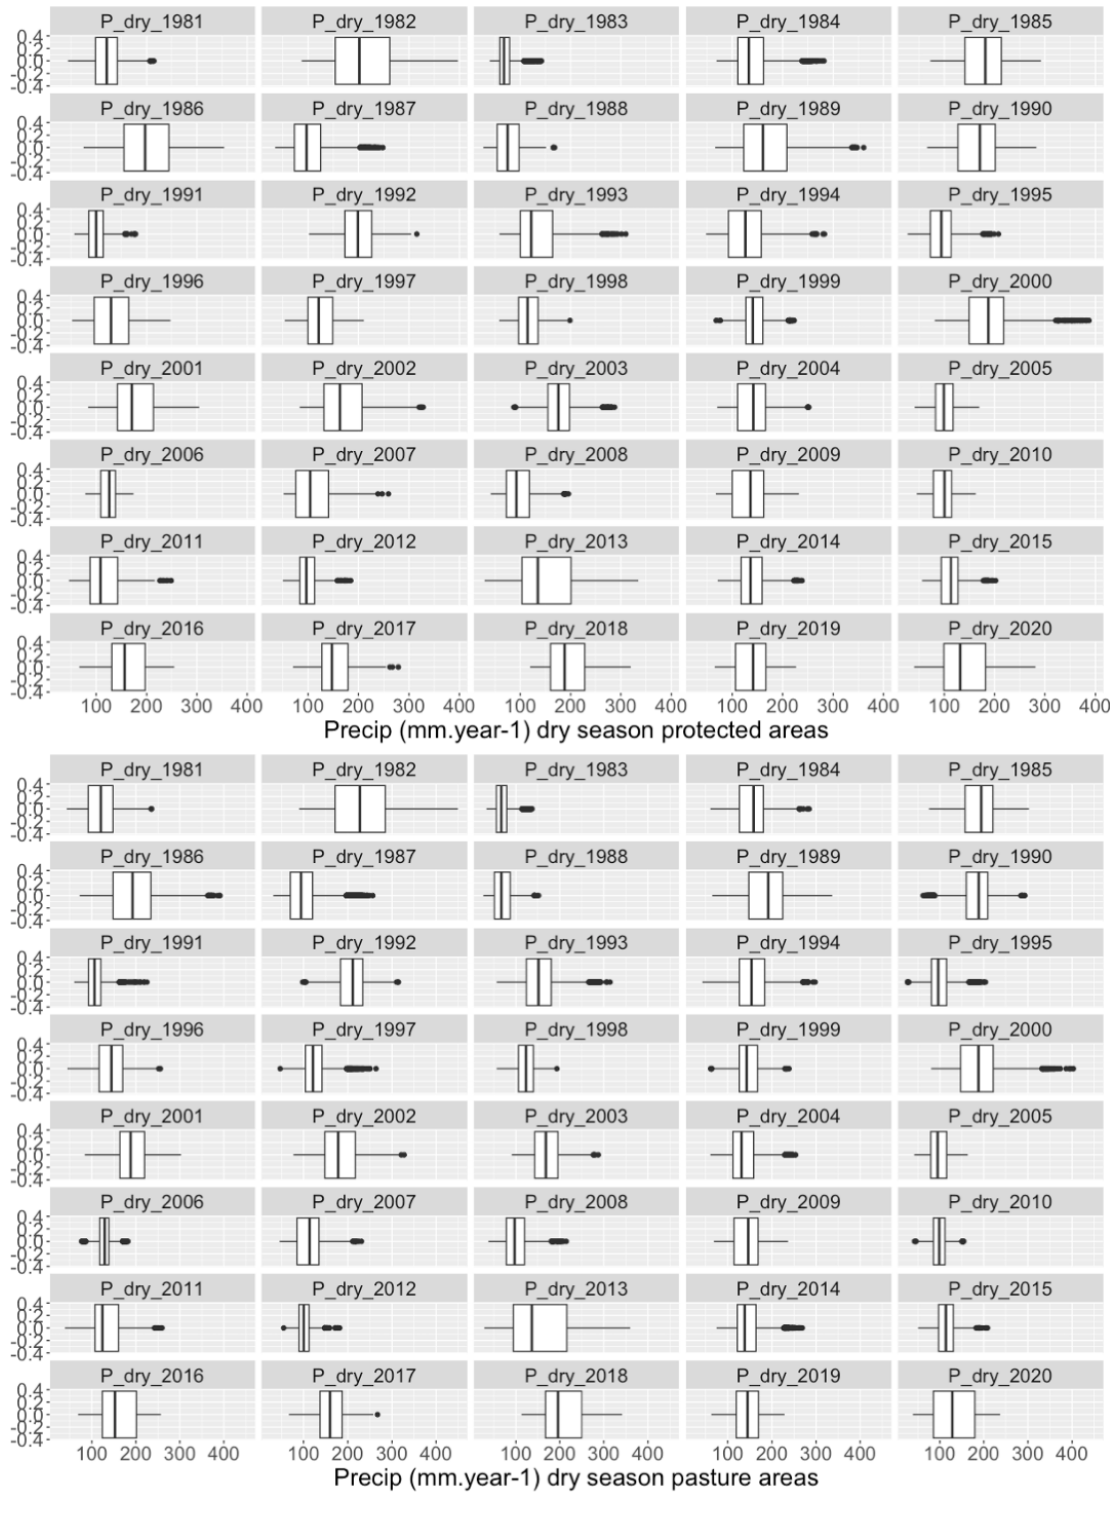
Figure 11. Boxplot of yearly accumulated rainfall for the dry season in Rondônia for the years 1981 to 2020 using CHIRPS data. These are the mean values of all valid pixels of CHIRPS images for protected and pasture areas.